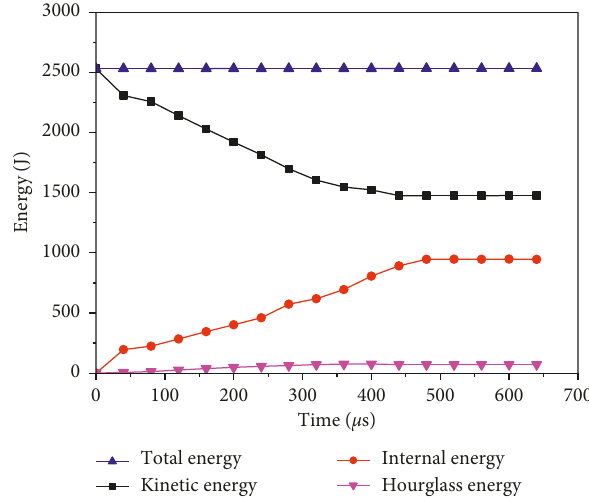
Figure 12: Time history curves of energy balance for impacting analysis (0-3). Table 5: Comparison with antiperforation performance of targets with different steel liner layouts.